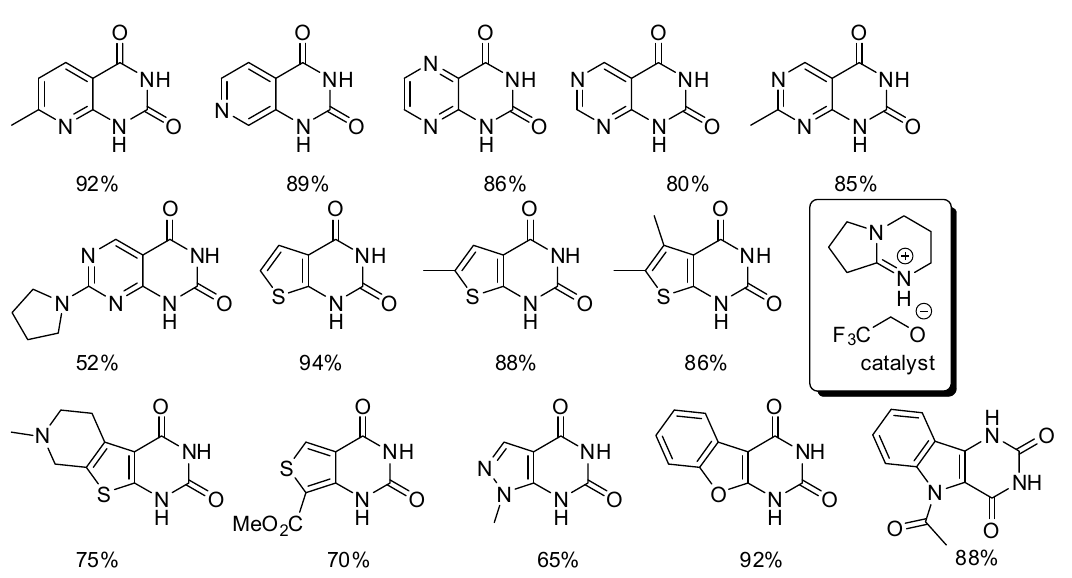
Table 5. Catalysts for the reaction of 2-aminobenzonitriles and CO